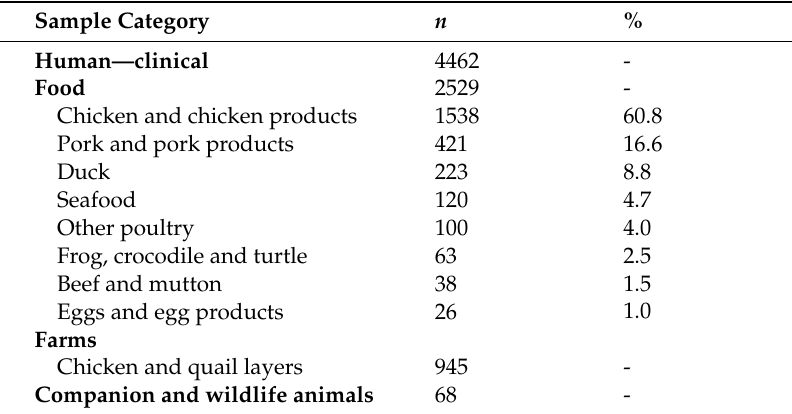
Table 1. Number of Salmonella isolates included in this study